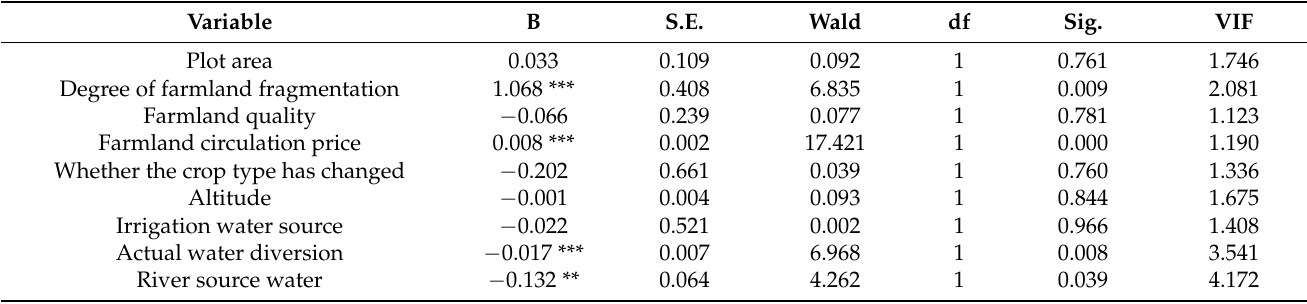
Table 7. Logistic regression results at plot level in plain areas.